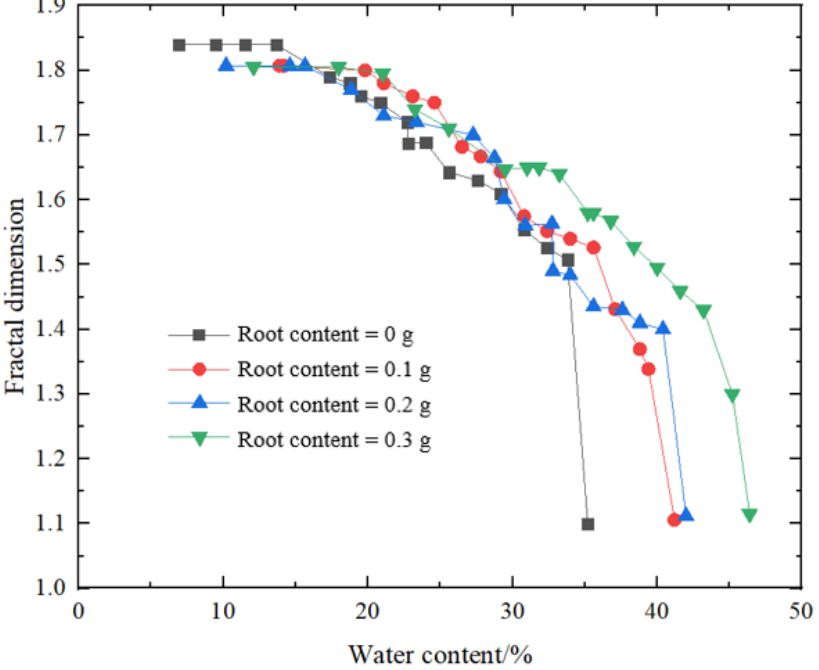
Figure 8. Relationship between fractal dimension of soil fissure and water content.